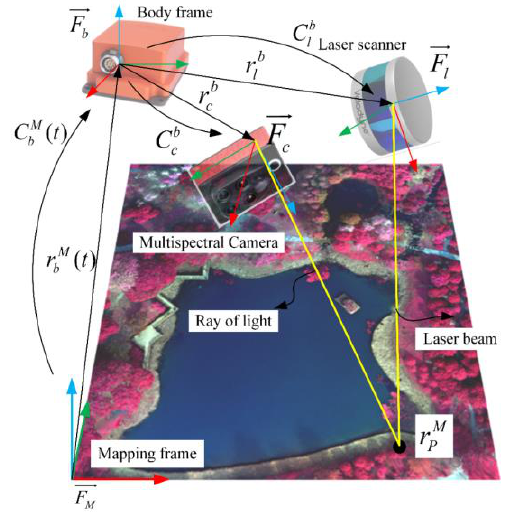
Fig.2 Coordinate definitions involved in the proposed multisensory UAV